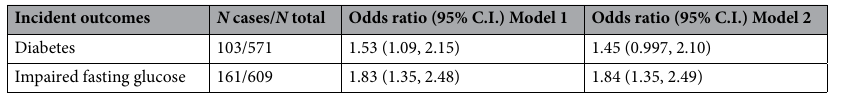
Table 2. Association of insulin-related SNV genetic risk score with incident diabetes and impaired fasting glucose. All analyses are adjusted for age, sex, center, case-control status, principal components (Model 1) and additional adjustments for BMI (Model 2). C.I. confidence interval, N number. All outcomes were obtained at follow-up visit. Genetic risk score was calculated by the unweighted sum of increasing insulin risk alleles of the SNVs (chr6:79,650,711, rs760461668, rs756851199,